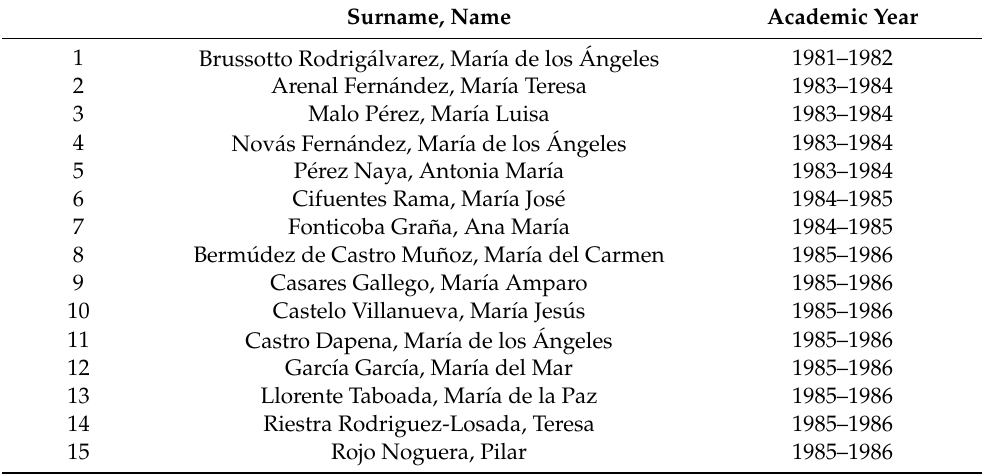
Table A1. Female architects who graduated in the School of Architecture in A Coruña (1981–1986).